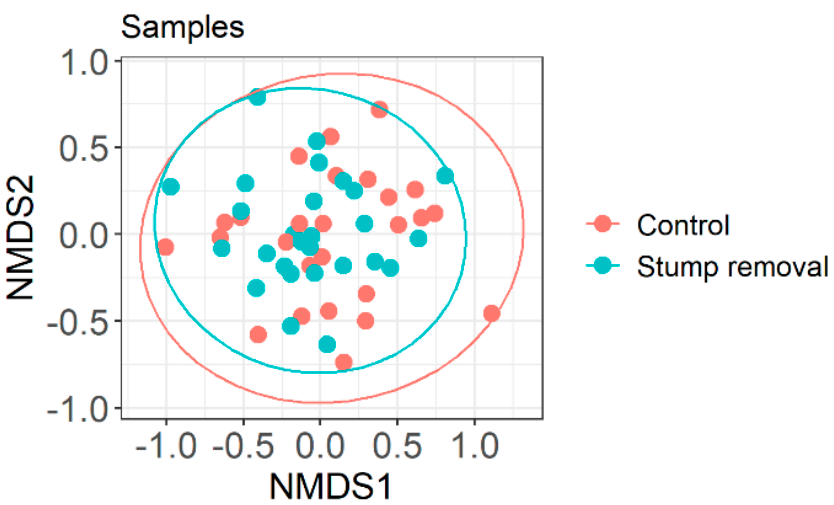
Figure 4. Non-metric multidimensional scaling (NMDS) ordination for fungal communities (pres- ence/absence data of fungal OTUs) as a function of sampling site management history (stump removal (red) vs. control (blue) samples). Ellipses indicate 95% confidence intervals for each sample group.